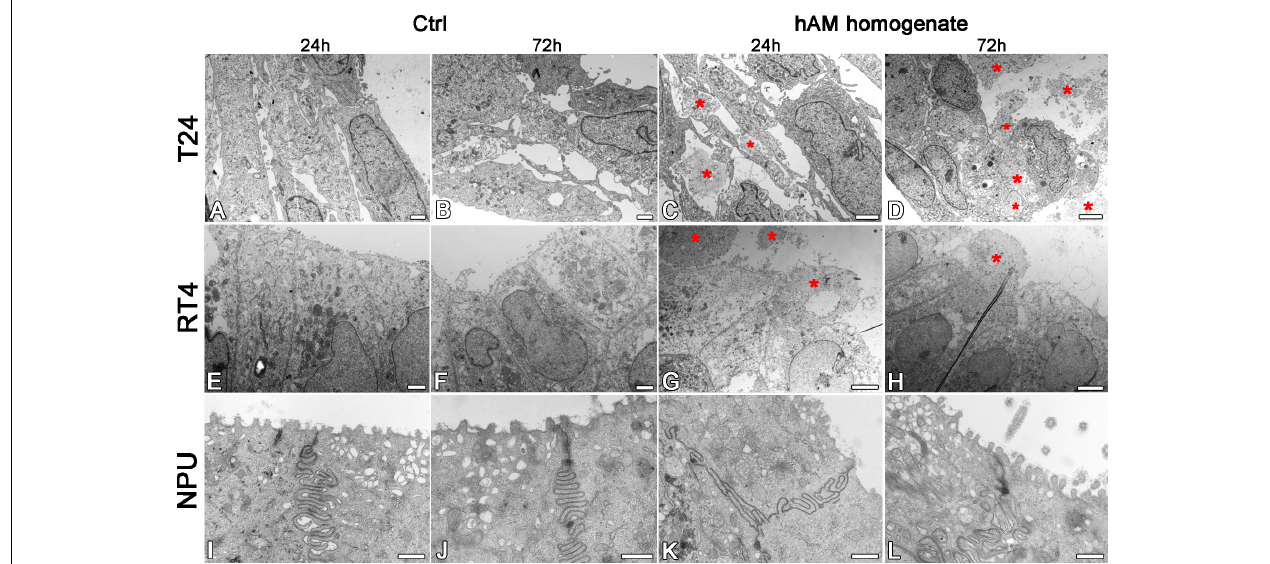
FIGURE 8 | The hAM homogenate adheres to the surface of T24 and RT4 cells, but not the NPU cells, and incorporates between T24 cells. (A,B) The T24 cells incubated in culture medium for 24 or 72 h had mesenchymal morphology and there were large intercellular spaces between the cells. (C,D) The hAM homogenate (red asterisks) adhered to the surface of T24 cells and incorporated into the intercellular spaces. (E,F) The RT4 cells incubated in culture medium for 24 or 72 h had epithelial morphology and were well connected. (G,H) Incubation in hAM homogenate for 24 or 72 h had no significant effect on RT4 cell morphology. The hAM homogenate (red asterisks) adhered to the surface of RT4 cells. Some RT4 cells begin to desquamate. (I,J) The NPU cultures incubated in culture medium 24 or 72 h retained the typical ultrastructure of well-differentiated normal urothelial cells. (K,L) Incubation in hAM homogenate for 24 or 72 h had no significant effect on NPU cell morphology, and the hAM homogenate did not adhere to the surface of NPU cells. All data shown here were obtained from at least three independent replications of experiments using three biological samples of hAM; each experiment was performed in 1–2 technical repeats for each condition. Scale bars: (A,B) 1 µ m, (C) 2 µ m, (D) 4 µ m, (E,F) 10 µ m, (G) 8 µ m, (H) 6 µ m, (I,L) 600